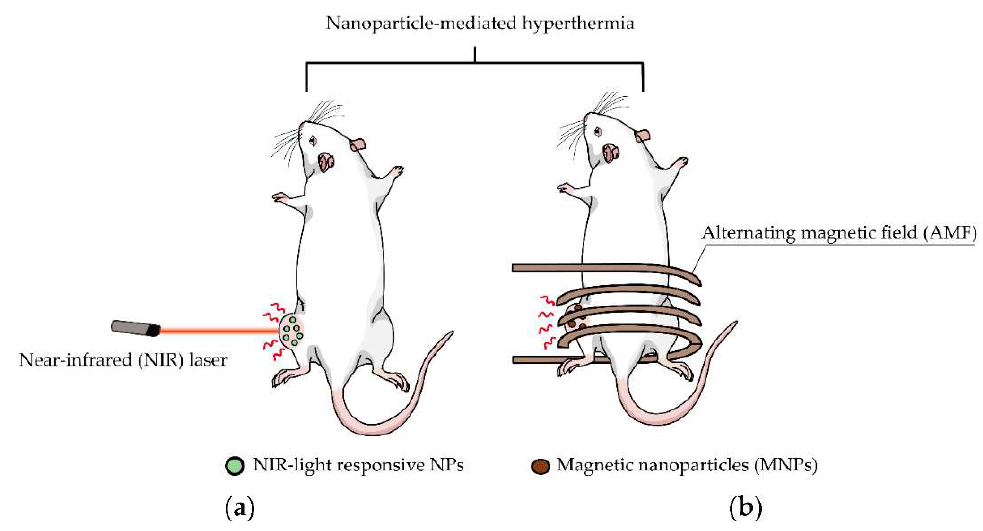
Figure 2. Schematic of hyperthermia utilizing nanoparticles: ( a ) photothermal treatment with laser irradiation to the cancer site, and ( b ) magnetic hyperthermia therapy with magnetic field exposure [21].